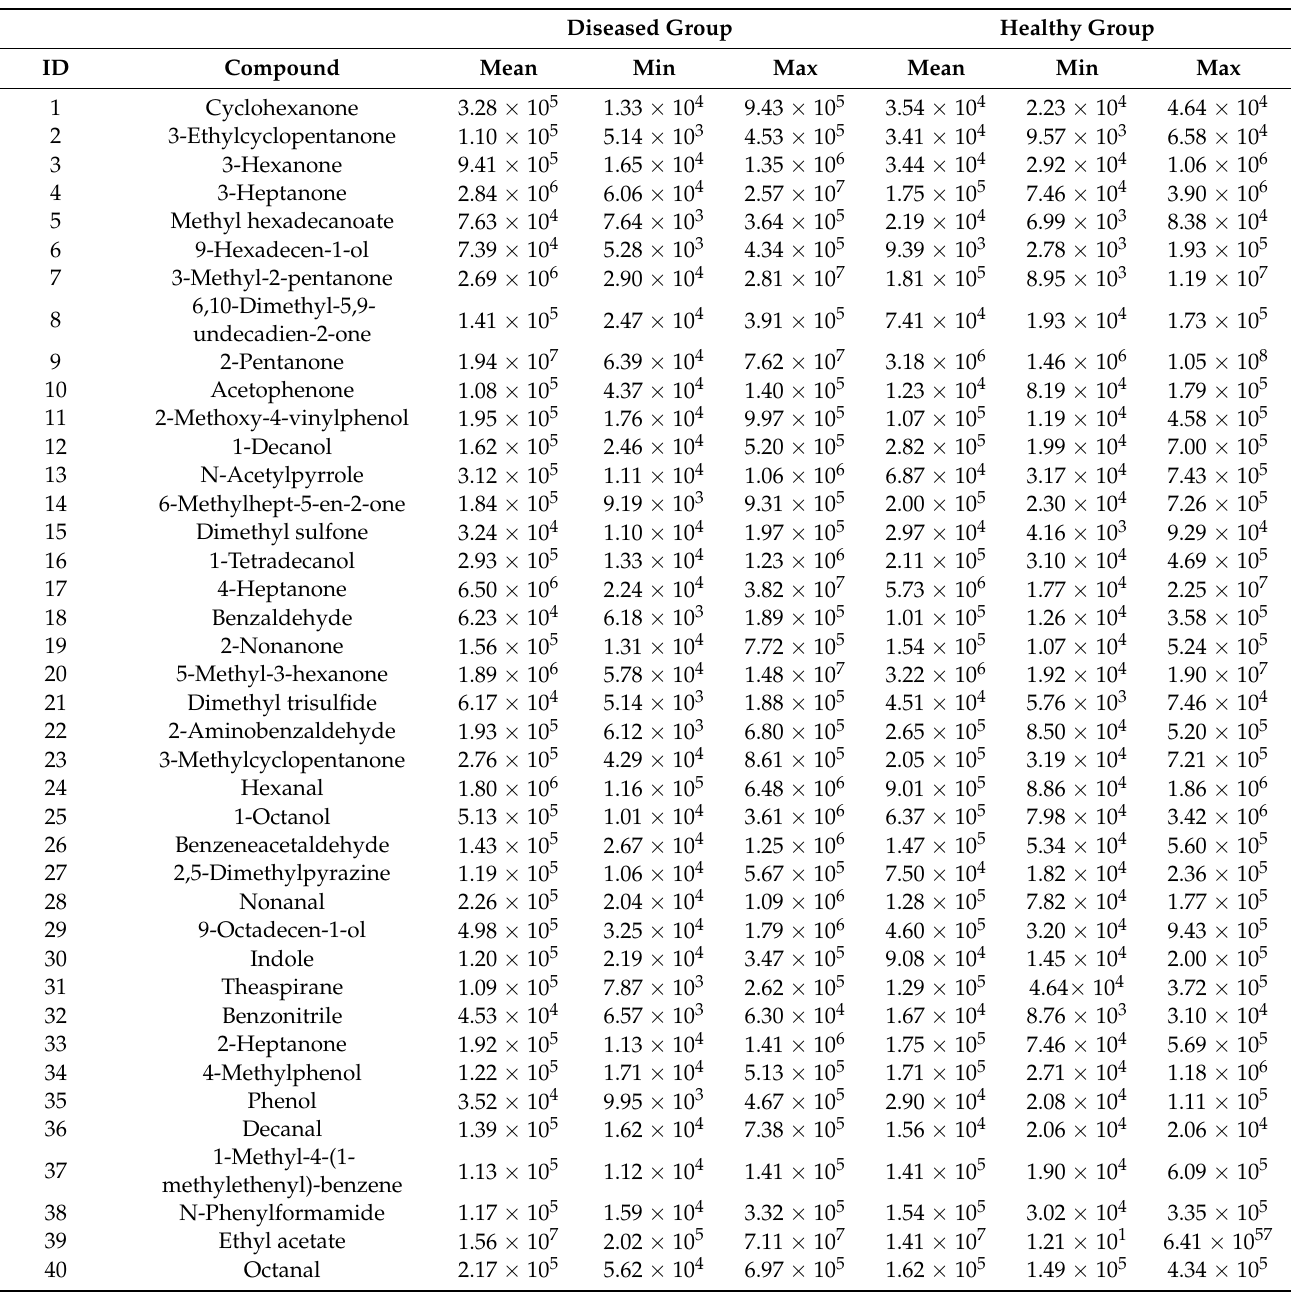
Table 2. Descriptive statistics of the VOCs defined in higher concentration in urine by patients suffering from glomerular diseases, where: min–minimum,